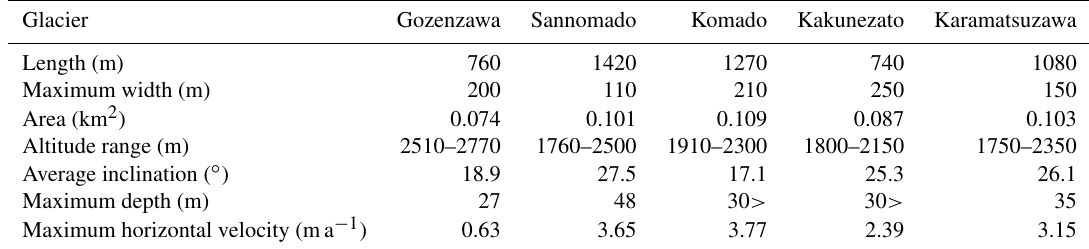
Table 1. Physical properties of the glaciers. Maximum depth and maximum horizontal velocity at Gozenzawa, Sannomado, Komado, and Kakunezato glaciers are from Fukui et al.